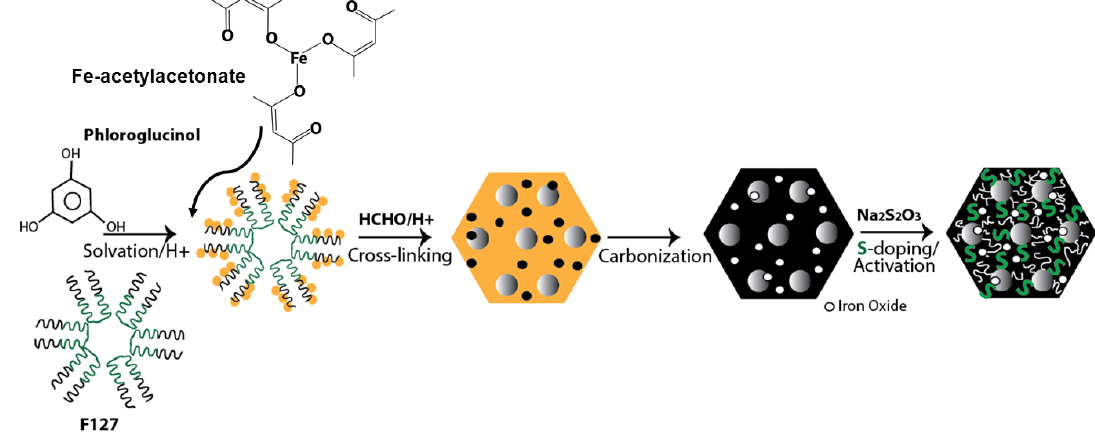
Figure 1. Schematic of synthesis of iron and sulfur dual-doped mesoporous carbon.